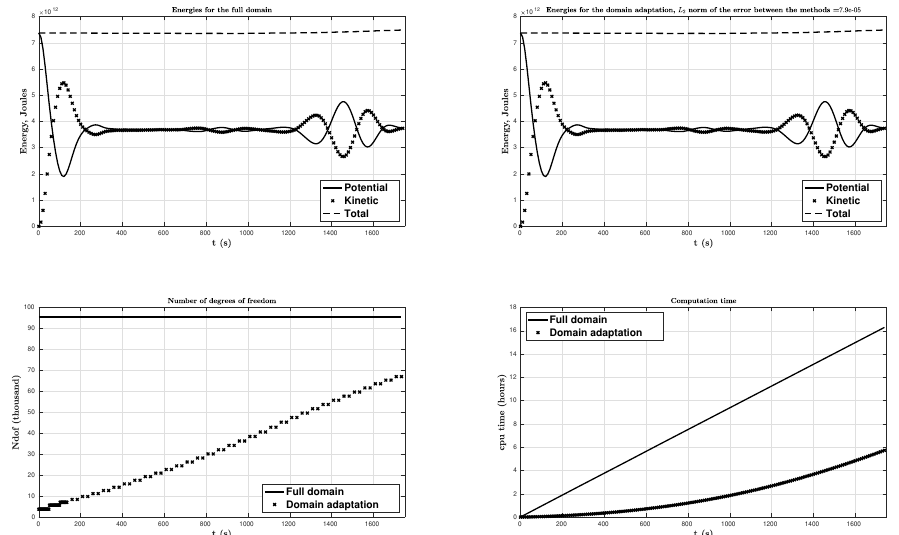
Figure 17. Passive generation: comparison between the two methods the full one and domain adaptivity of the kinetic, potential and total energies, the number of degrees of freedom, and the computation time of the